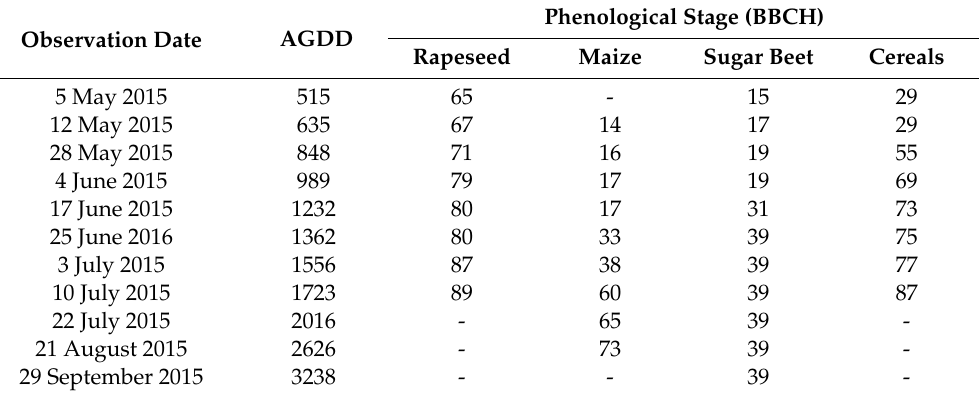
Figure 1. Mosaic of the study area near Mönchaltorf in the canton of Zurich (red dot and grey shaded area in the overview map of Switzerland, bottom left), acquired over 1362 accumulated growing degree days ( AGDD, i.e., 25 June 2015) with a consumer-grade RGB camera mounted on a UAV, superimposed by the ground reference data from the same date. Table 1. Observation dates, corresponding accumulated growing degree days (AGDD) and phenological stage (represented as BBCH) of a single reference field per crop type. Cereals are represented by phenological stage of winter wheat.